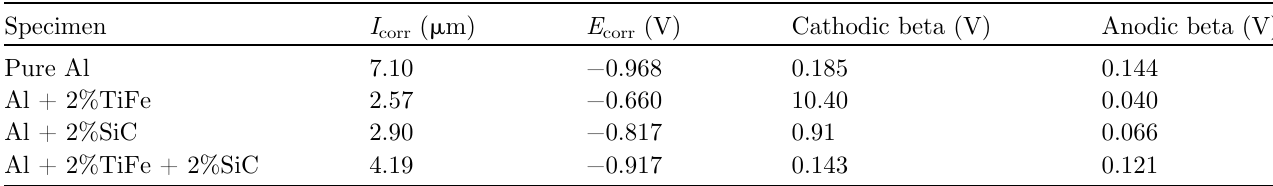
Table 2. Tafel properties of pure aluminium and composites. Specimen